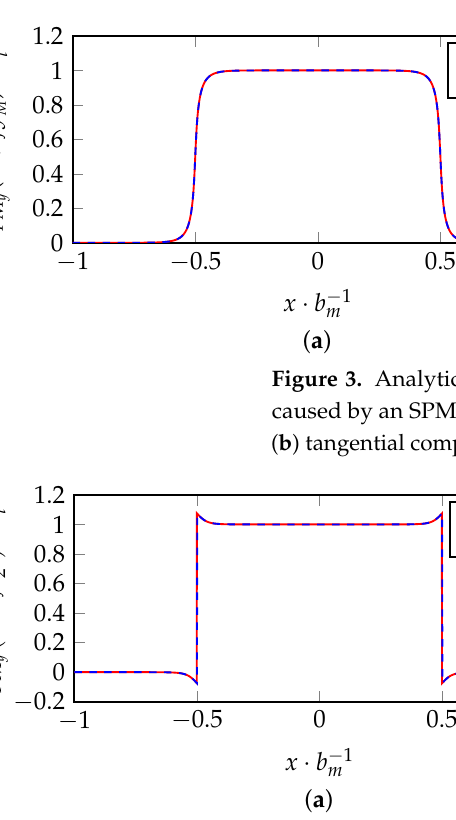
Figure 4. Analytical and FEM flux density distributions on the middle PM line, caused by an SPM between two smooth iron surfaces (